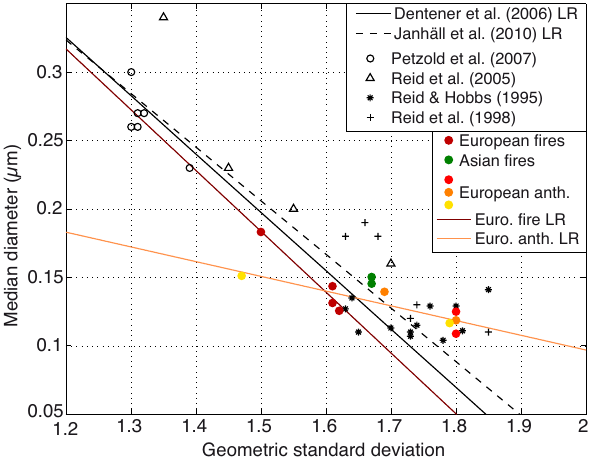
Fig. 15. Modal mean diameters for the accumulation mode of for- est fire aerosol size distributions as a function of their geometric standard deviations. Values for the European anthropogenic plumes are indicated for comparison. Linear regression (LR) from earlier studies and for fires and anthropogenic plumes are also